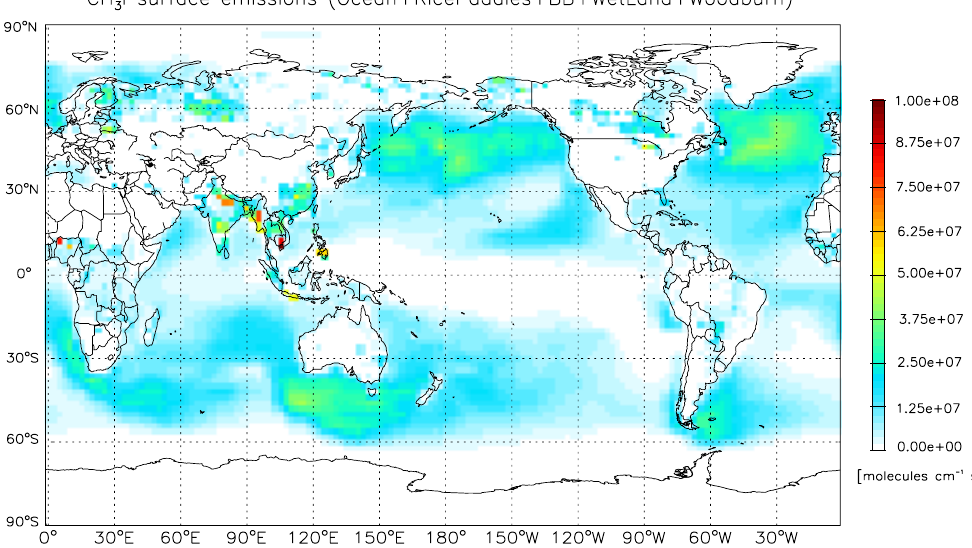
Fig. 2. Annual average surface emission fluxes of CH 3 I in the unit of molecules cm − 1 s − 1 . The emissions include fluxes from ocean, rice paddies, biomass burning, wetlands, and wood burning to the atmosphere.